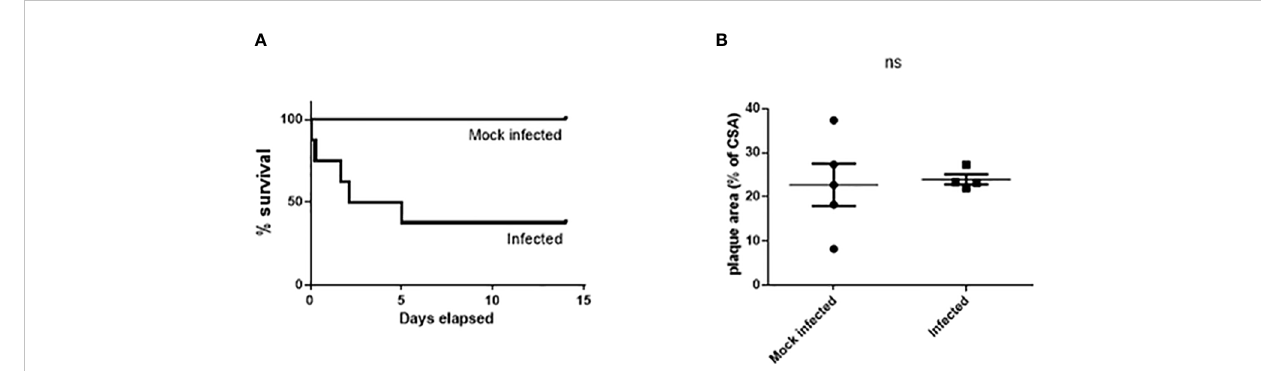
FIGURE 1 Signi fi cant mortality but no signi fi cant effect on atherosclerosis burden in male Paigen fed ApoE -/- mice following Type 1 S. pneumoniae infection.